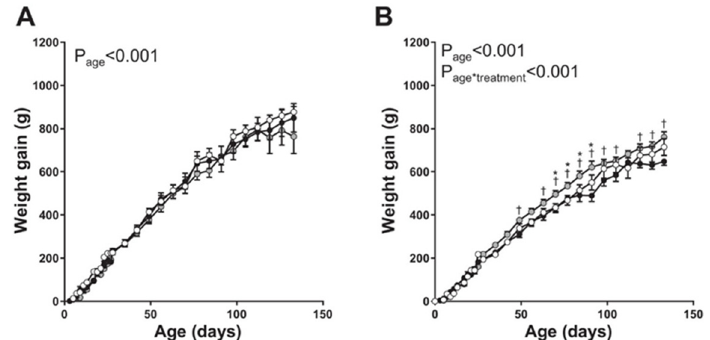
Figure 5. Postnatal weight gain in male ( A ) and female ( B ) offspring of sham-treated control sows (open circles; n = 7 male pups, n = 13 female pups), offspring of sows undernourished to induce FGR (solid circles; n = 6 male pups, n = 13 female pups), and offspring of sows undernourished and given adenoviral vascular endothelial growth factor A 165 (Ad.VEGF-A 165 ) gene therapy (shaded circles; n = 8 male pups, n = 10 female pups). * p < 0.05 vs. controls; † p < 0.05 vs. untreated FGR at same age. Modified from [75].